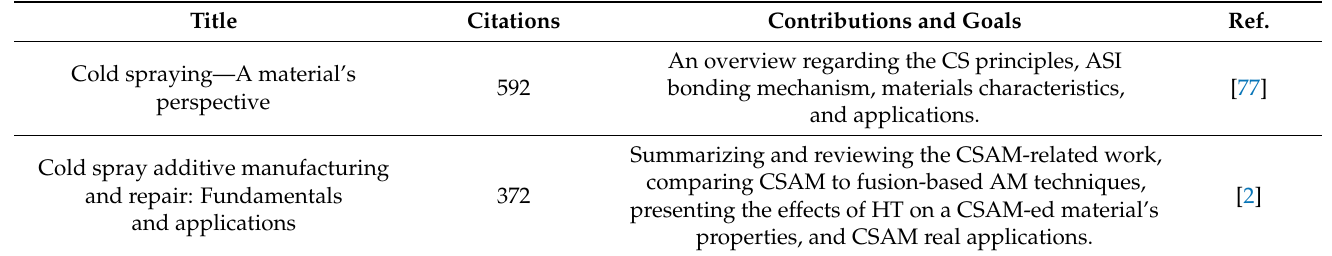
Figure 17. Number of documents by country. Table 4. The articles most cited in CSAM